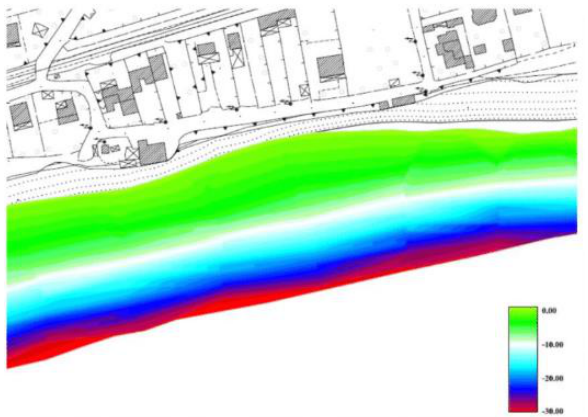
Figure 10 . Echosounder bathymetry